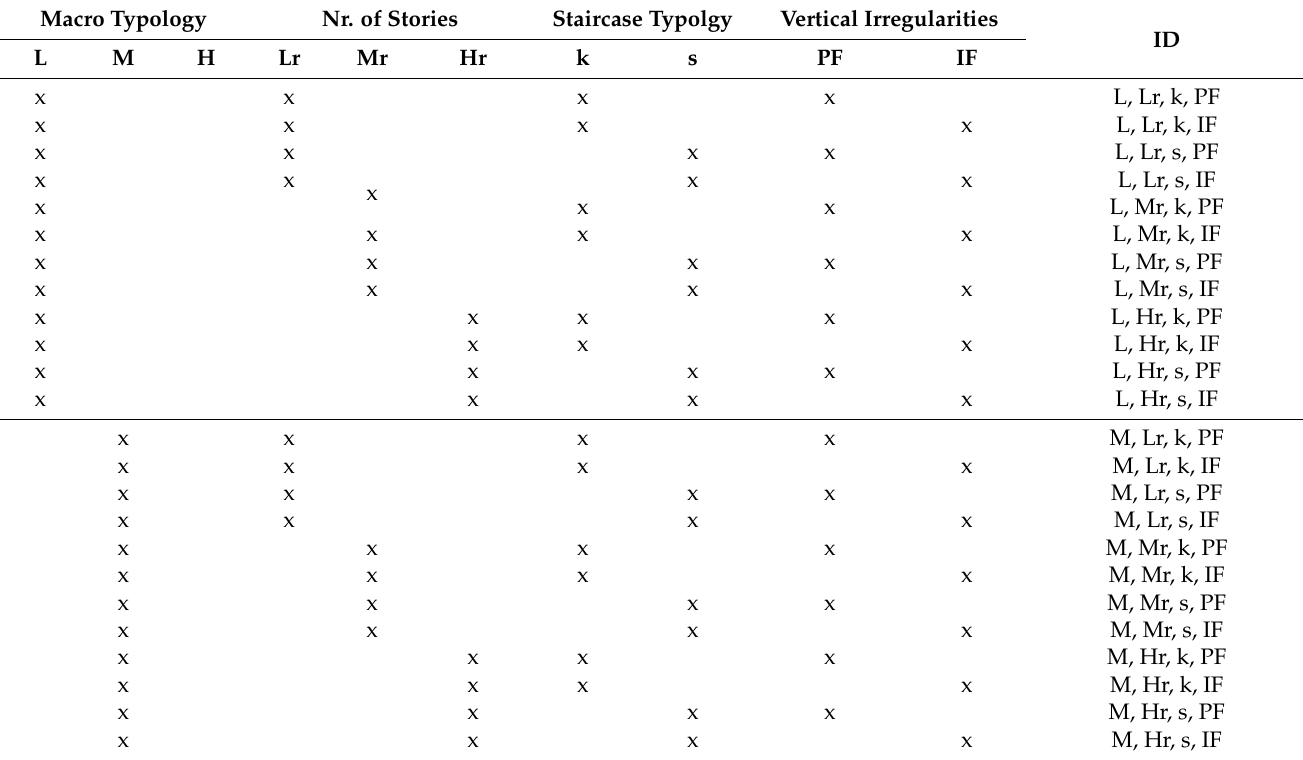
Table 3. Building typologies